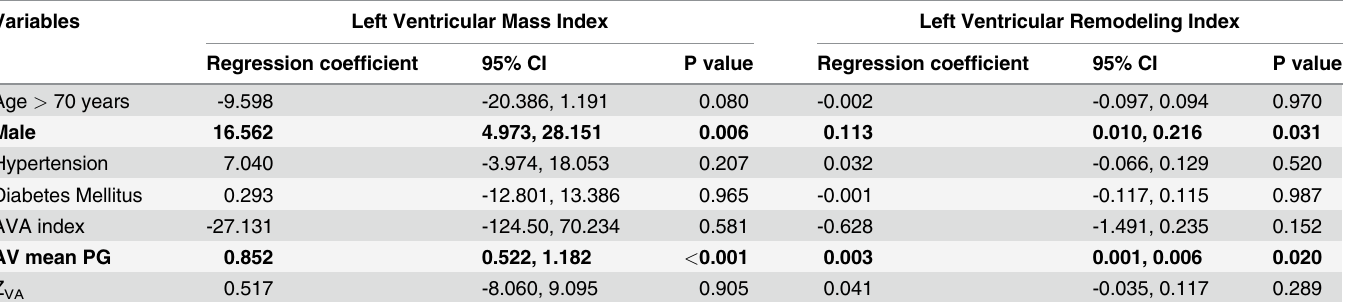
Table 6. Determinants of left ventricular mass index or left ventricular remodeling index with exclusion of the patients with moderate AS. †